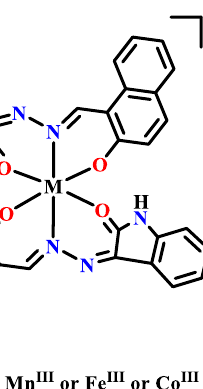
Figure 1. Some representative first transition metal complexes of naphthylhydrazone with N -phenylamino derivatives as the side chain.